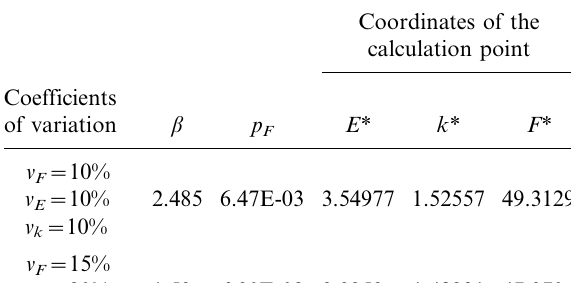
Table 5. Example results with the sensitivity coefficients Coordinates of